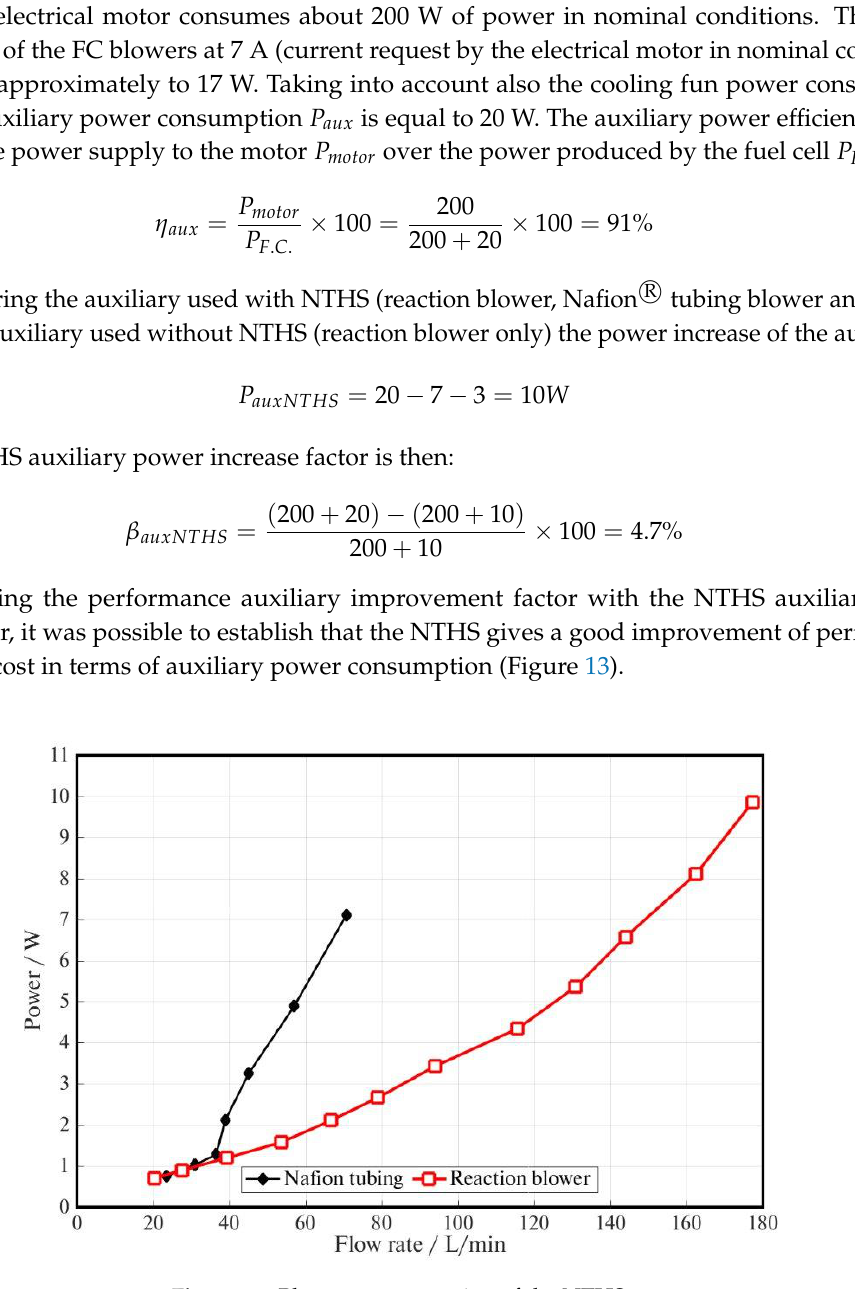
Figure 13. Blowers consumption of the